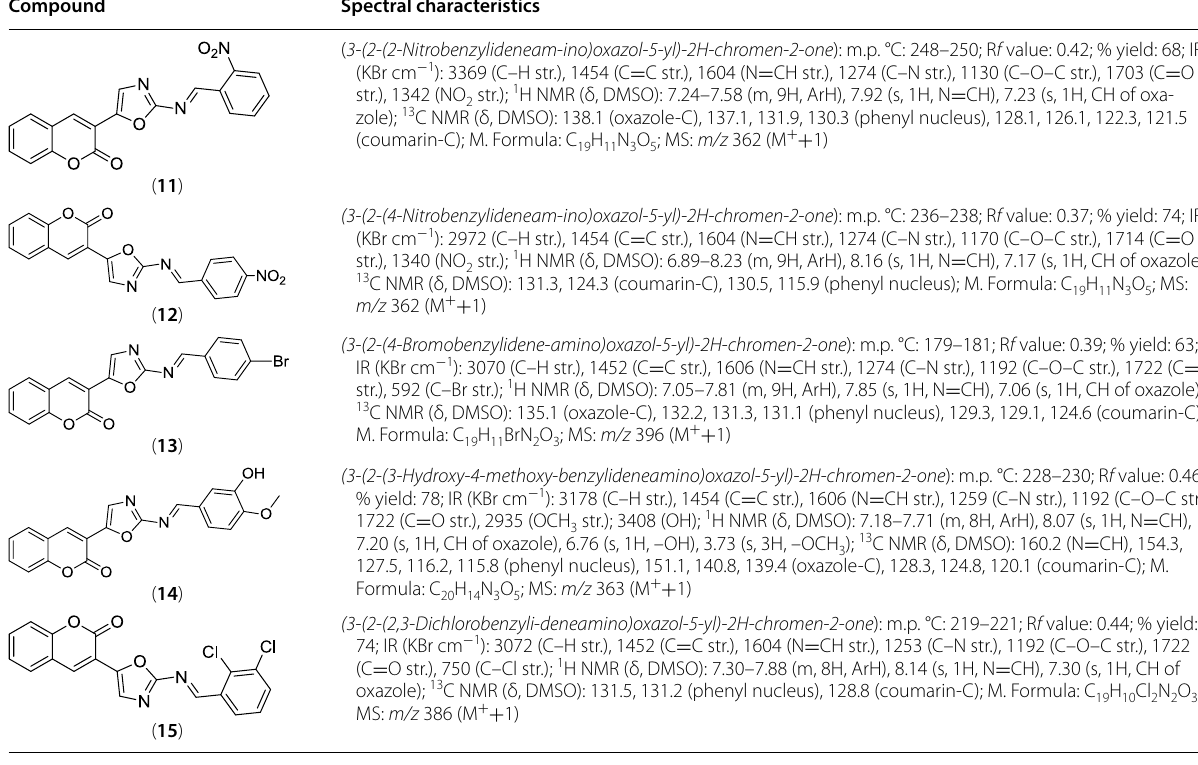
Table 2 In vitro antimicrobial activity of the synthesized compounds